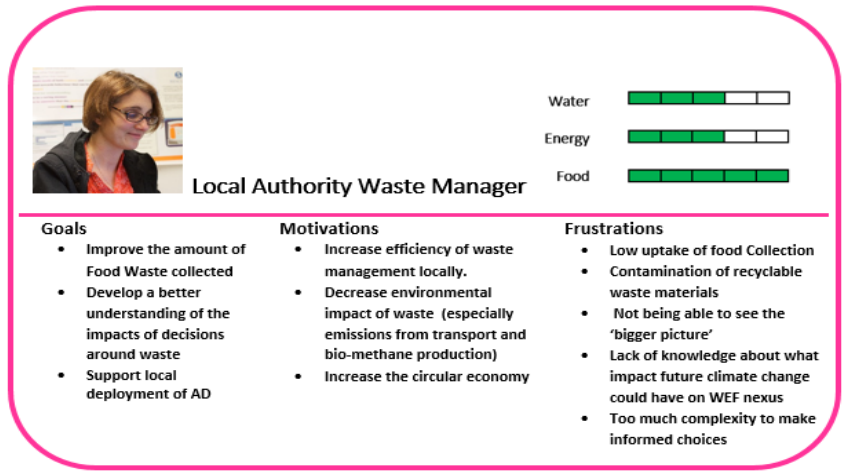
Figure 1. Example of a Persona developed for the Stepping Up project Decision Support Tool.